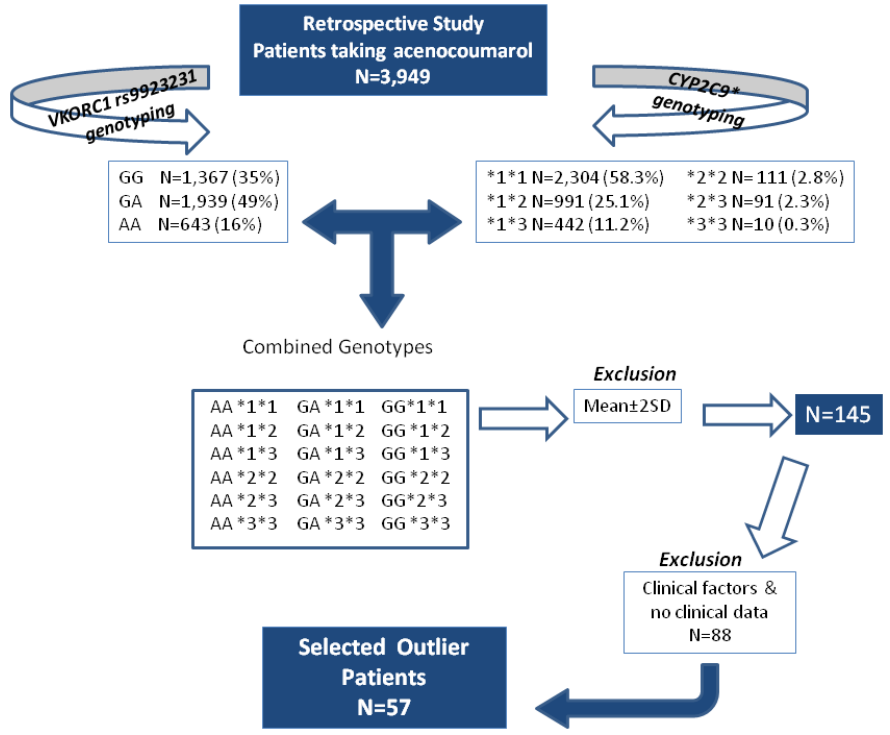
Figure 1. Study design: selection of patients from a retrospective cohort of subjects anticogulated with acenocoumarol (N=3949).